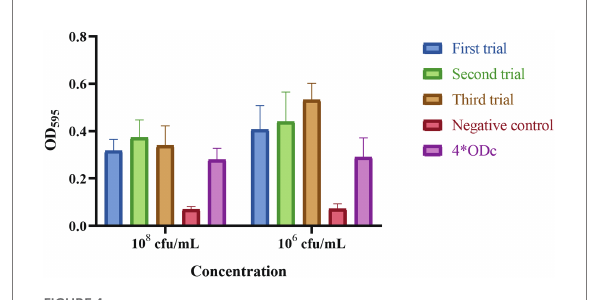
FIGURE 4 The biofilm biomass of K. pneumoniae DY1928. In the figure, ODc is the mean OD of the negative control. Criteria for judgment are: non-biofilm formation, ODc ≥ ODs; weak biofilm formation, ODc < ODs ≤ 2*ODc; moderate biofilm formation, 2*ODc < ODs ≤ 4*ODc; strong biofilm formation, 4*ODc < ODs (ODs is the mean OD of the samples).